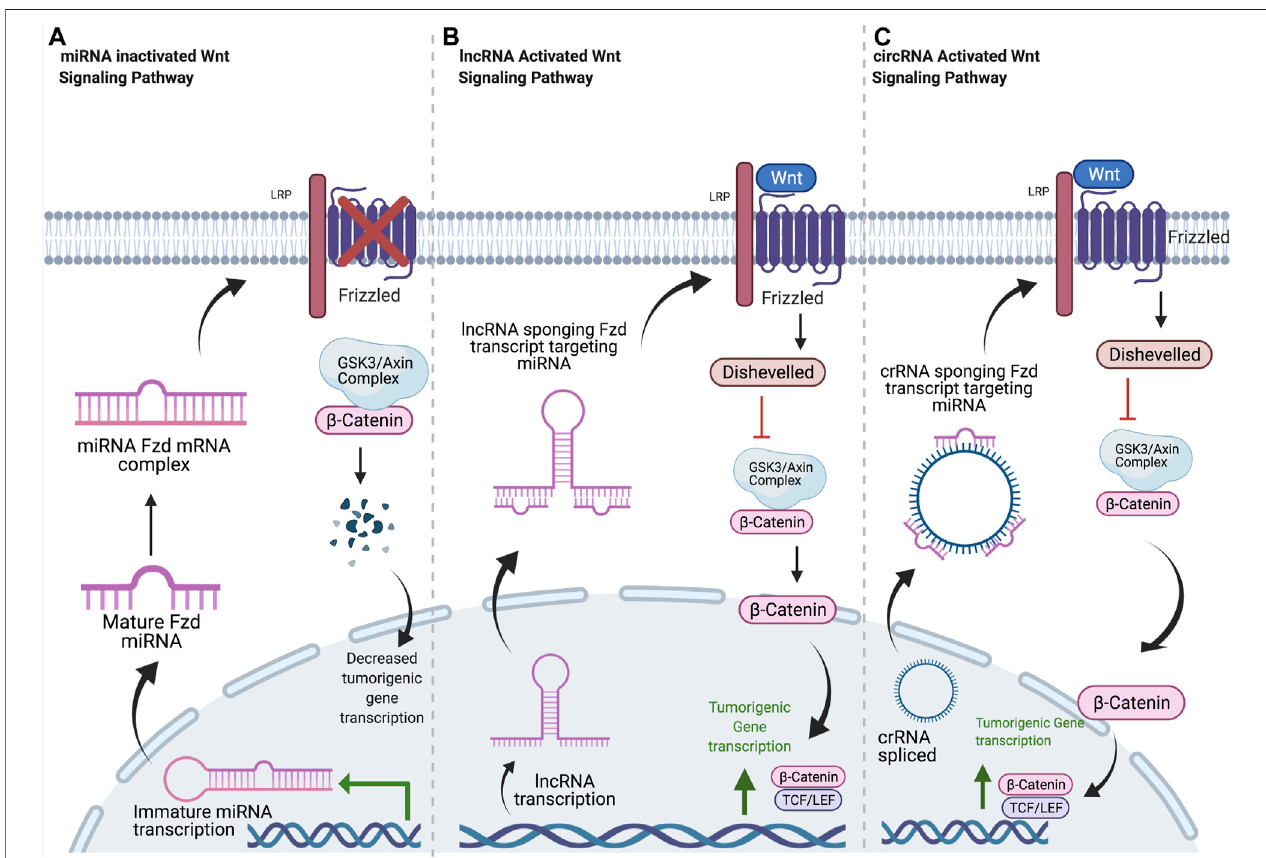
FIGURE 1 | Common mechanisms of ncRNA regulation of Frizzled receptors. (A) Mature miRNA oligonucleotides target Fzd transcripts, blocking translation. DecreasedFzdattheplasmamembraneresultsindecreased β -cateninlocalizationtothenucleusanddecreasedtranscriptionoftumorigenicsignalingcomponents. (B) Once in the cytosol, lncRNA transcripts sequester miRNA oligos with complementary sequences. This allows for normal Fzd protein expression, leading to increased β -Cateninsignalingandtumorigenicity. (C) circRNAissplicedandreleasedintocytosol.circRNAspongesmiRNAoligoswithcomplementarysequences,resulting in increased Fzd expression and increased tumorigenic signaling through β -catenin. Created with BioRender.com.